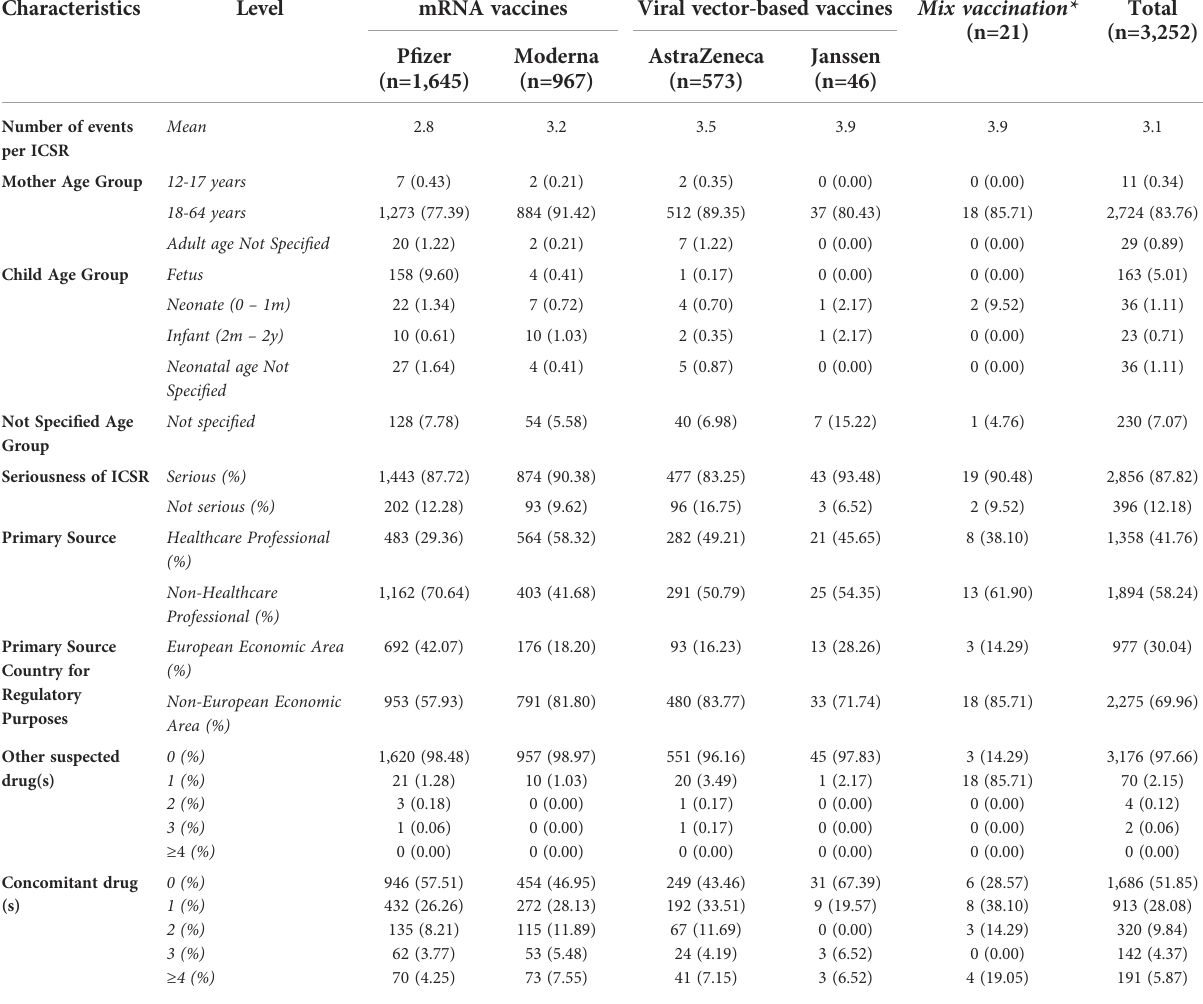
TABLE 1 Distribution for age group, seriousness, primary source, primary source country for regulatory purposes, presence of other suspected or concomitant drugs among Individual Case Safety Reports (ICSRs) related to the maternal exposure during pregnancy to COVID-19 vaccines reported in EudraVigilance from 1 January 2021 to 31 December